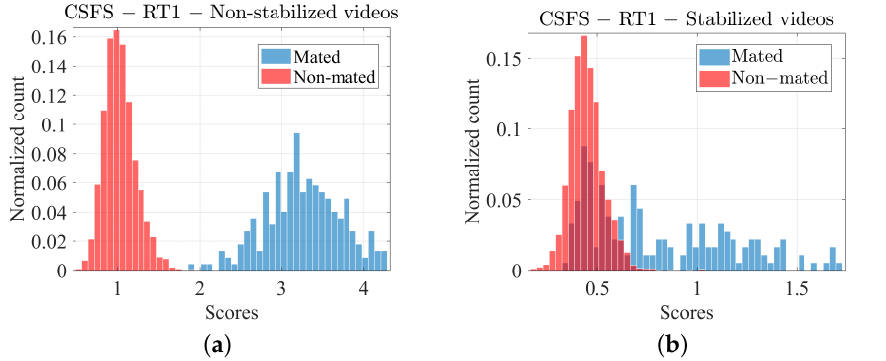
Figure 4. Histograms of empirical score distributions obtained from non-stabilized ( a ) and stabilized video recordings ( b ). The scores are obtained by using the reference Photo Response Non-Uniformity (PRNU) of type RT1 and by applying the Cumulated Sorted Frame Score (CSFS)